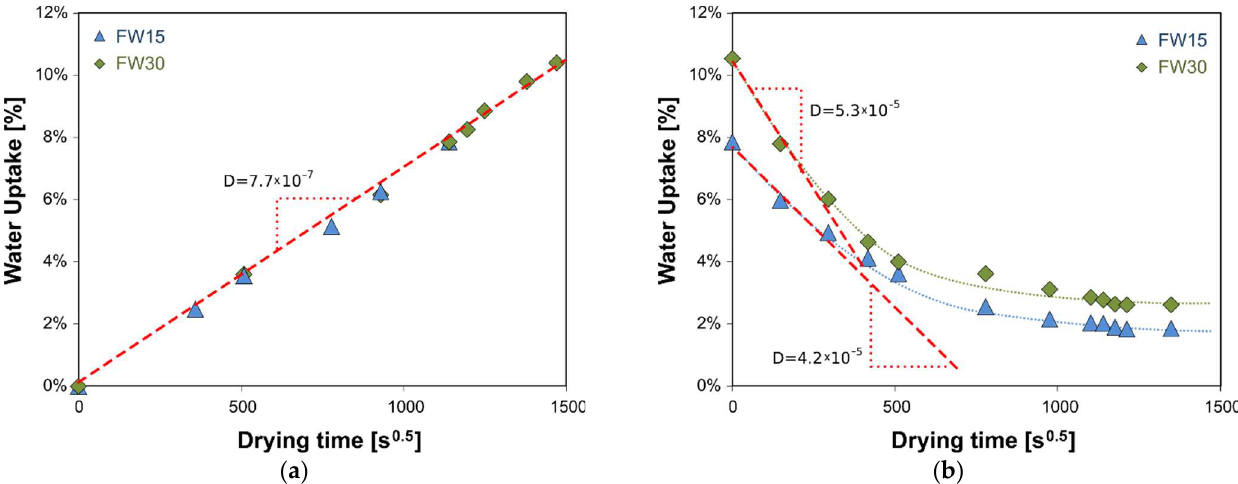
Figure 1. Water uptake evolution with increasing time during ( a ) wet and ( b ) dry stages for flax laminates. Red lines refer to curved slope.